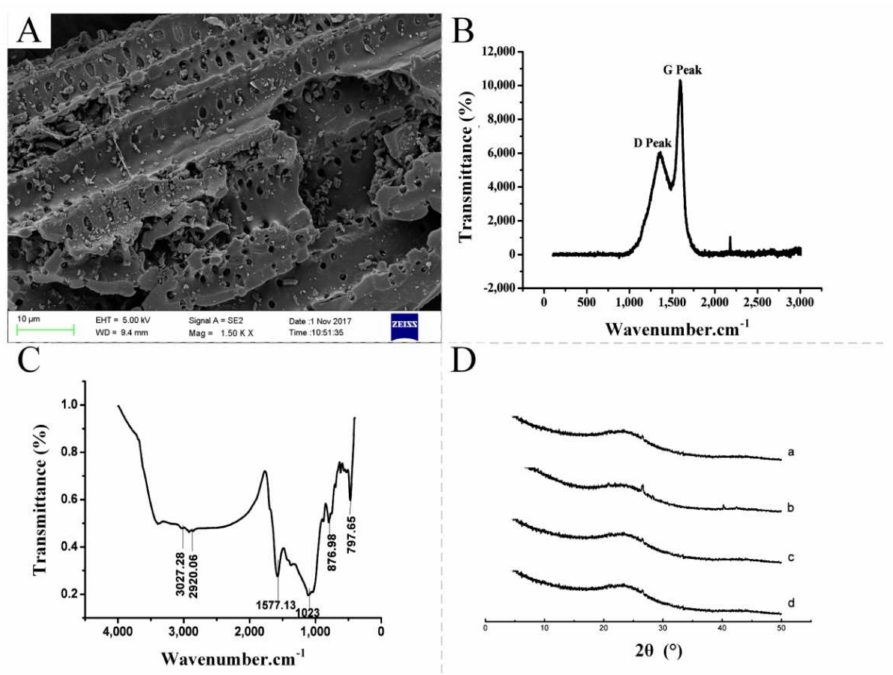
Figure 1. ( A ) SEM image of the bamboo charcoal at 1,500 × magnification; ( B ) Raman spectra of the bamboo charcoal; ( C ) FTIR spectra of the bamboo charcoal; and ( D ) XRD patterns of the bamboo charcoal in: air (a); HCl aqueous solution, pH 2 (b); NaOH aqueous solution, pH 12 (c); and methanol for 24 h